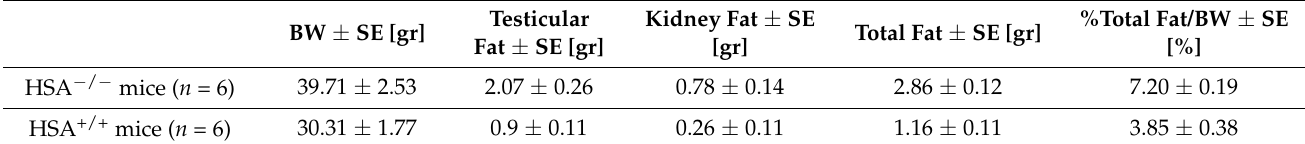
Table 3. Fat coefficient evaluation.